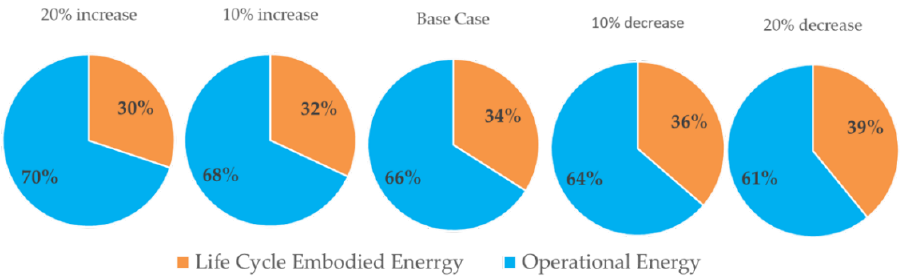
Figure 7. Proportion of Operational energy and Life cycle embodied energy based on variations in operational energy (Scenario 2).